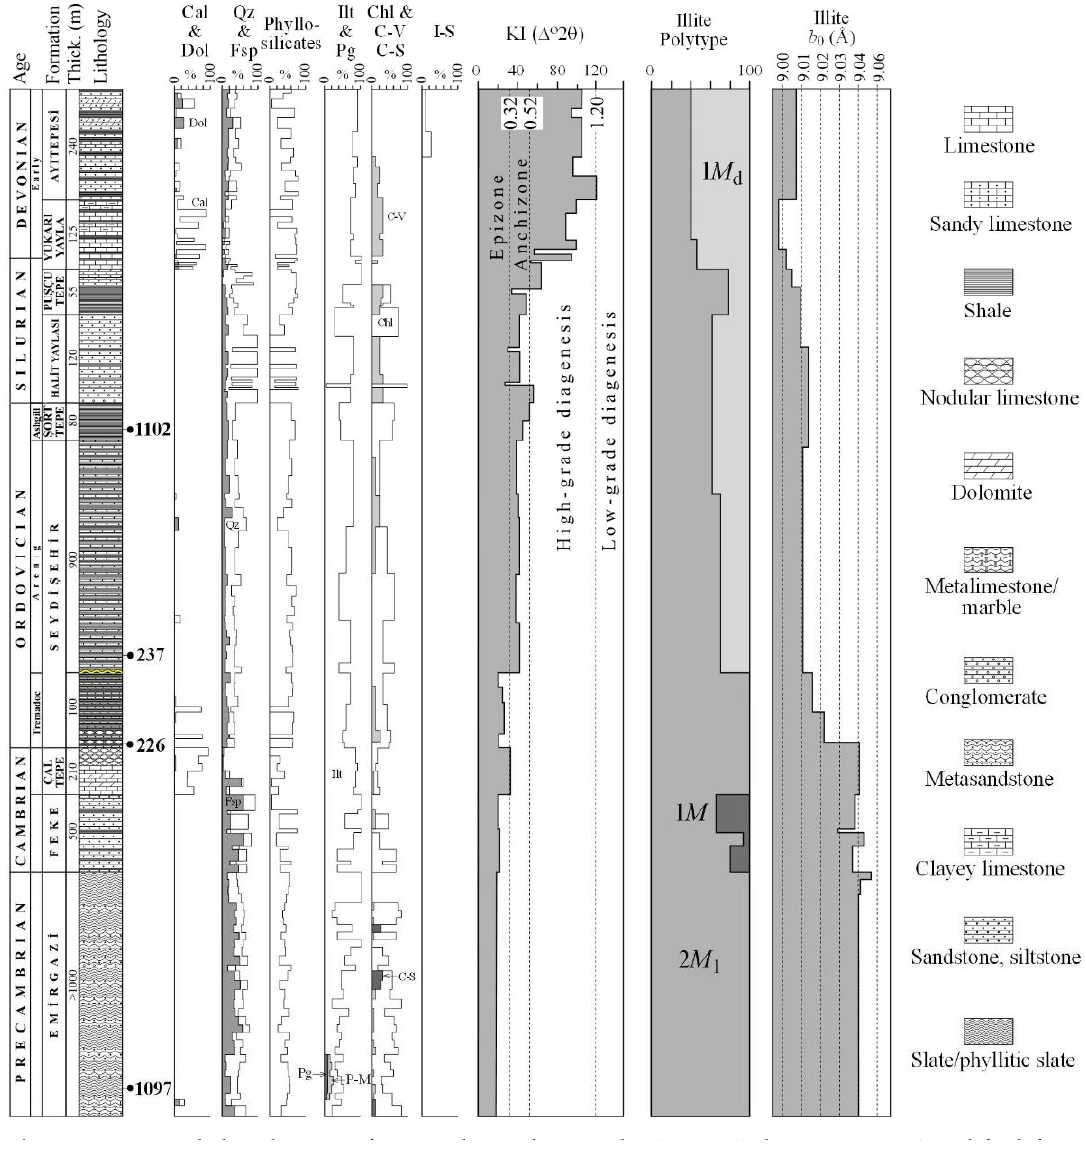
Figure 8. Vertical distribution of mineralogic data in the Lower Paleozoic units (Modified from [36]). Cal = Calcite, Chl = Chlorite, Dol = Dolomite, Fsp = Feldspar, Ilt = Illite, I-S = Mixed-layered illite- smectite, Ms = Muscovite, Pg = Paragonite, Qz = Quartz, C-S = Mixed-layered chlorite–smectite, C-V = Mixed-layered chlorite–vermiculite, KI = Illite Kübler index. There is a positive correlation among % KI, 2 M 1 %, and b 0 of illites/micas,